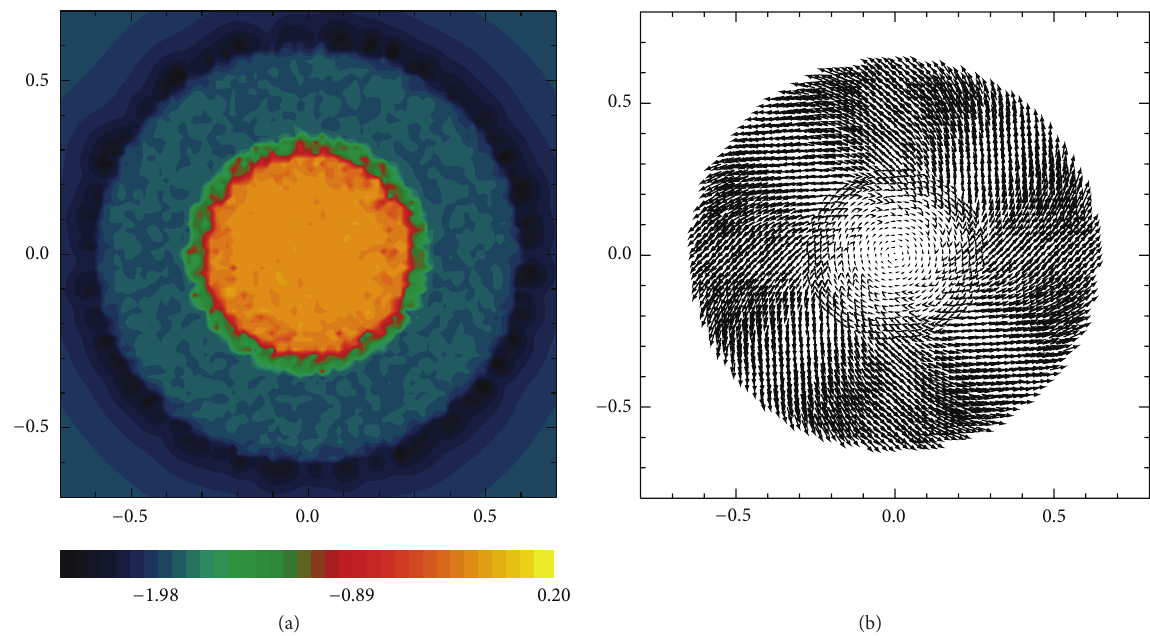
Figure 1: The initial configuration of particles (at time 0) for the wind models in the first and second scenarios. (a) Iso-density plot of the wind particles initially located in the red color area while the source particles are in the central yellow area. The blue color indicates an empty region. (b) Velocity plot of particles, where velocity is indicated by an arrow located at each particle